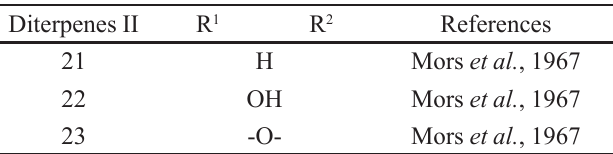
TABLE IV - Structure of the diterpenes based on molecule II , identified from the Pterodon genus Diterpenes II R 1 R